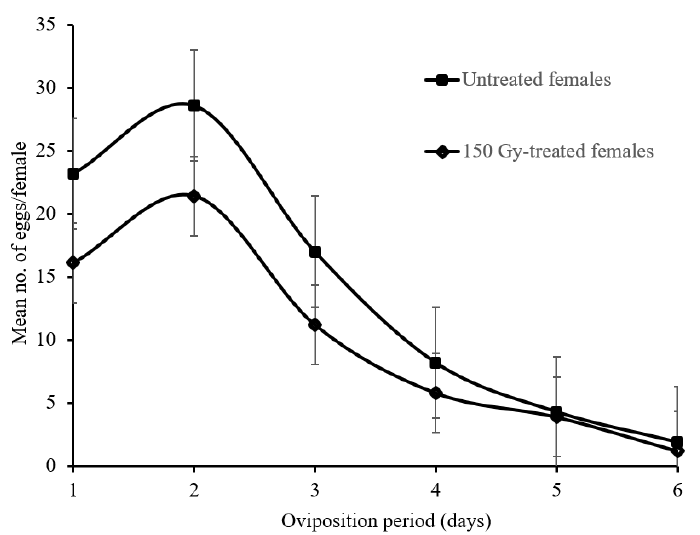
Figure 2. Mean number (±SD) of eggs laid by untreated and 150 Gy-treated Lobesia botrana females mated with untreated males according to the day of oviposition.